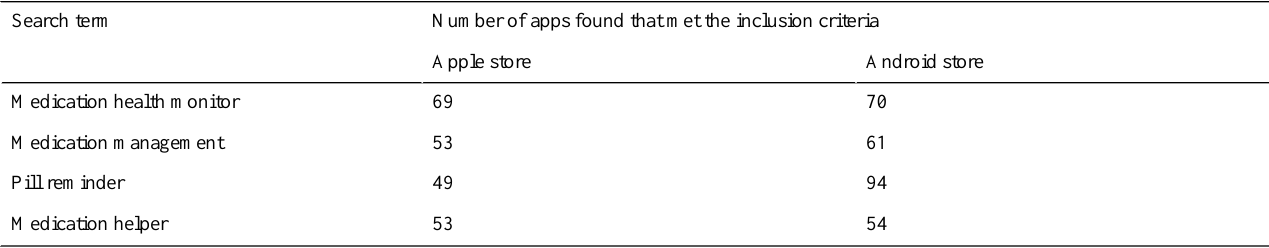
Table 1. Search terms and the number of eligible apps found with them in each app store.